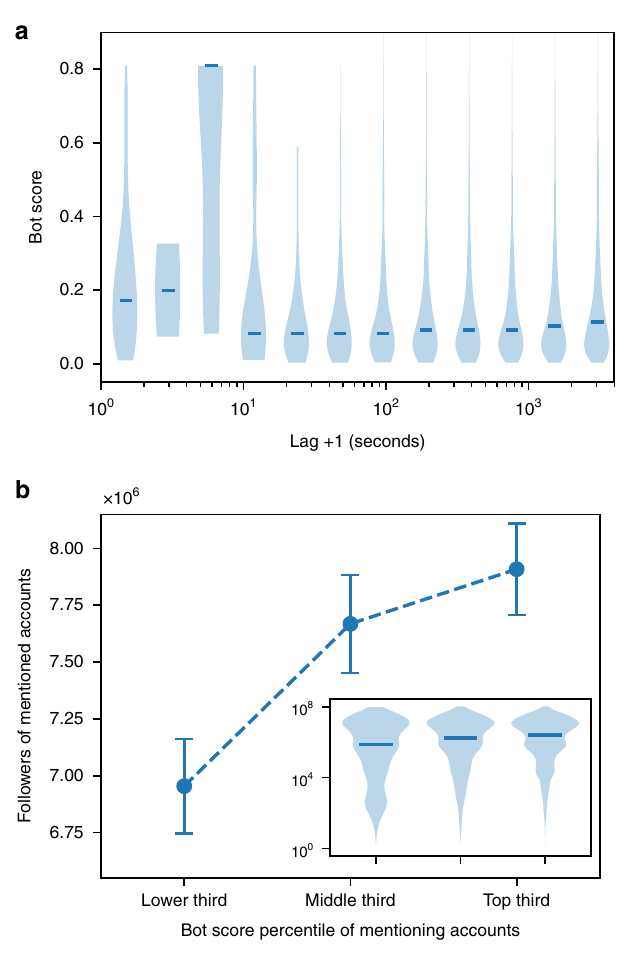
Fig. 3 Bot strategies. a Early bot support after a viral low-credibility article is fi rst shared. We consider a sample of 60,000 accounts that participate in the spread of the 1000 most viral stories from low-credibility sources. We align the times when each article fi rst appears. We focus on the 1 h early spreading phase following each of these events, and divide it into logarithmic lag intervals. The plot shows the bot score distribution for accounts sharing the articles during each of these lag intervals. b Targeting of in fl uentials. We plot the average number of followers of Twitter users who are mentioned (or replied to) by accounts that link to the most viral 1000 stories. The mentioning accounts are aggregated into three groups by bot score percentile. Error bars indicate standard errors. Inset: Distributions of follower counts for users mentioned by accounts in each